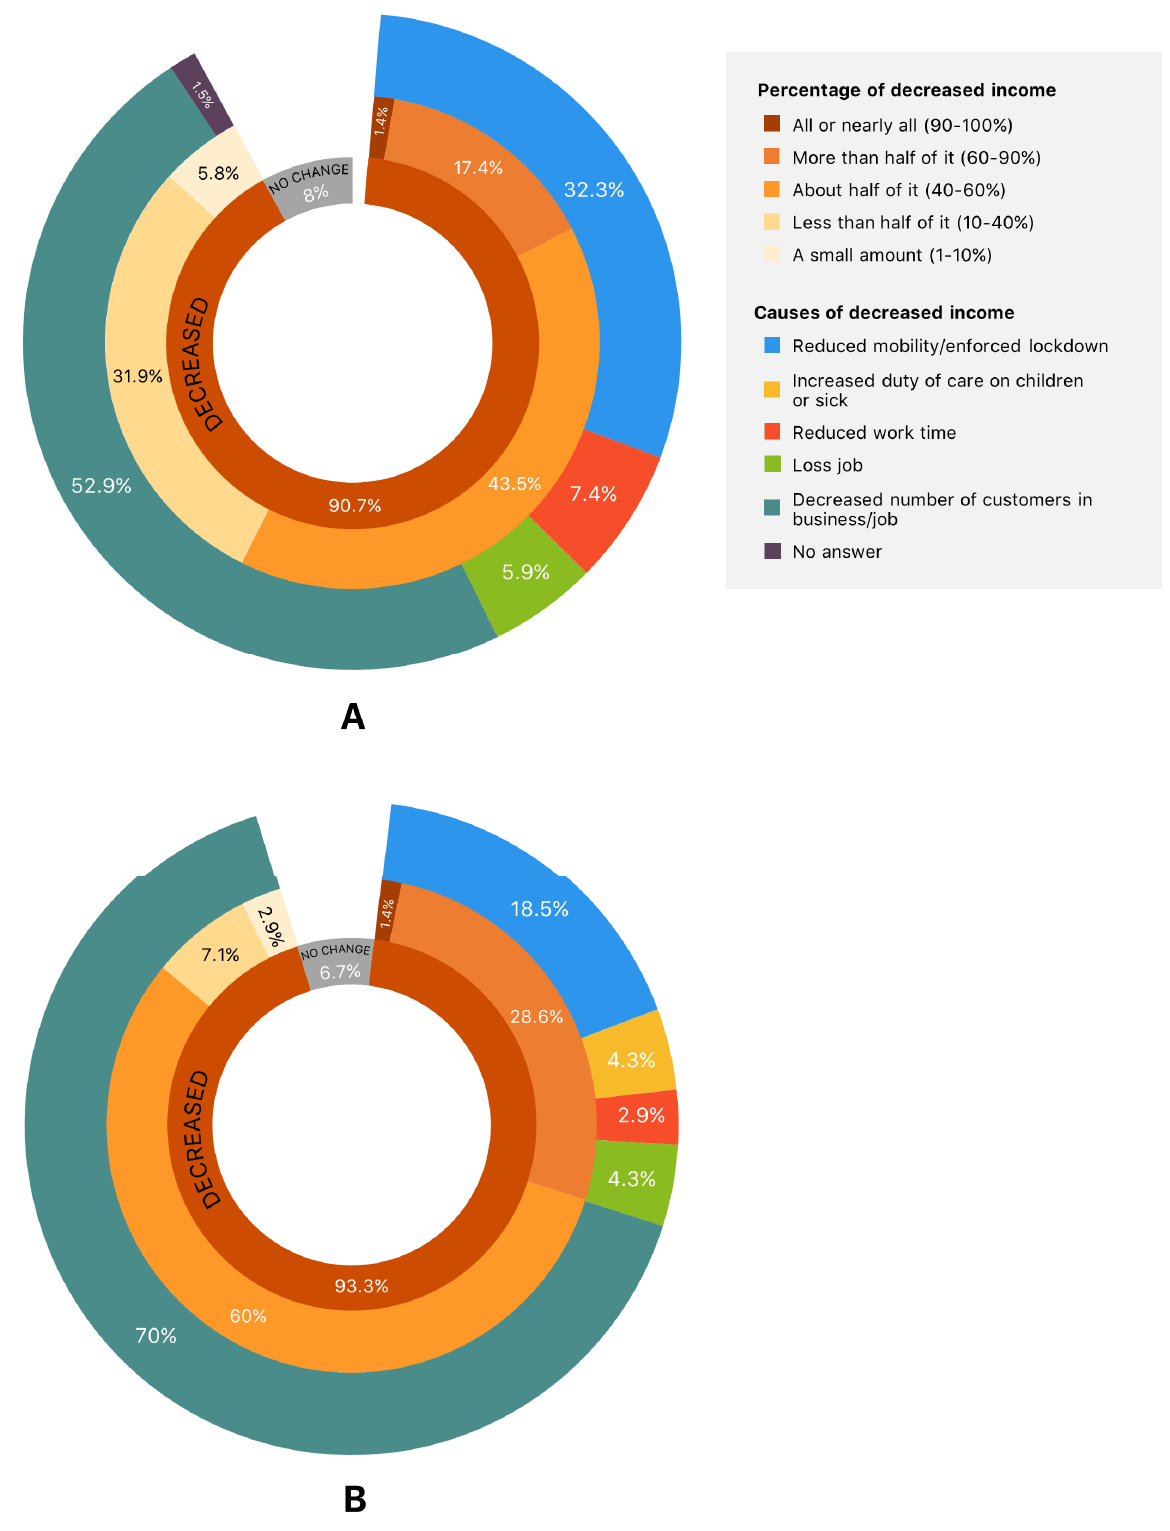
Figure 3. Impacts of COVID-19 on consumers’ incomes in ( A ) U/PU and ( B ) rural areas. The center and outermost charts detail the quantity and causes of income loss, respectively. The percentage for each item was computed using only retailers whose income had decreased (100% in total).